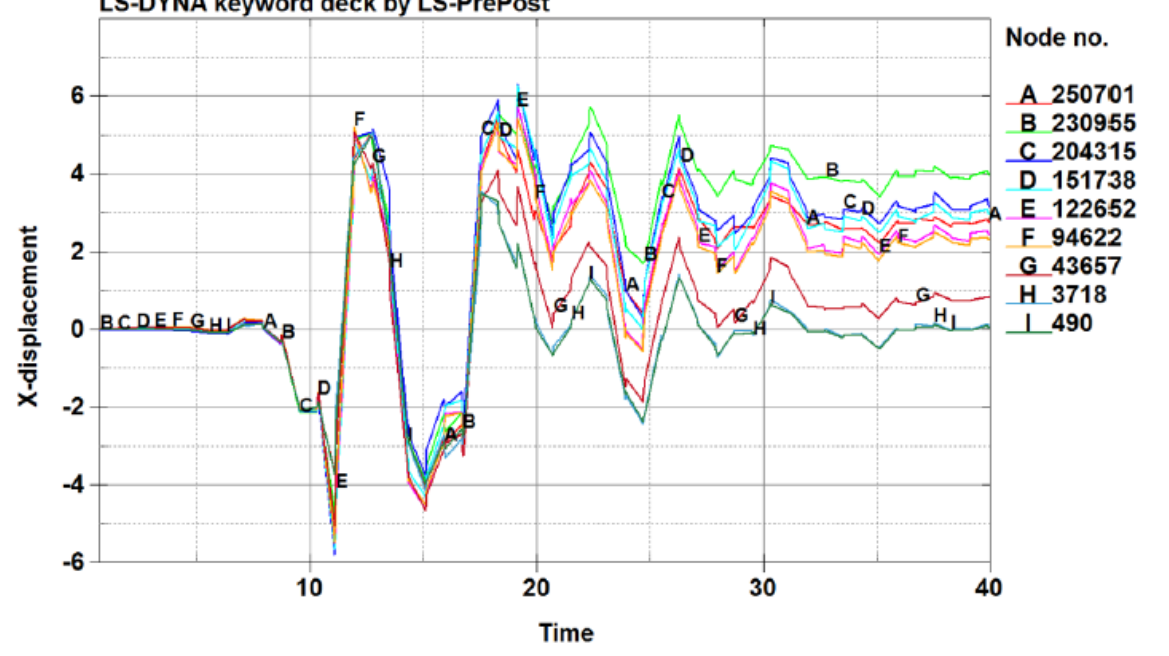
Figure 7. Plot of crest node displacement for the 5000-year, short-duration earthquake (MYG008) and 1-year strength parameters. (x-displacement is in inches, and time scale is in seconds. On the vertical axis, positive displacement is movement downstream, and negative ( − ) is movement up- stream).